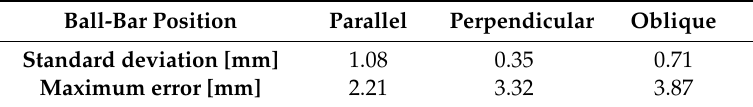
Table 3. The results of measurements of ball-bar in three different